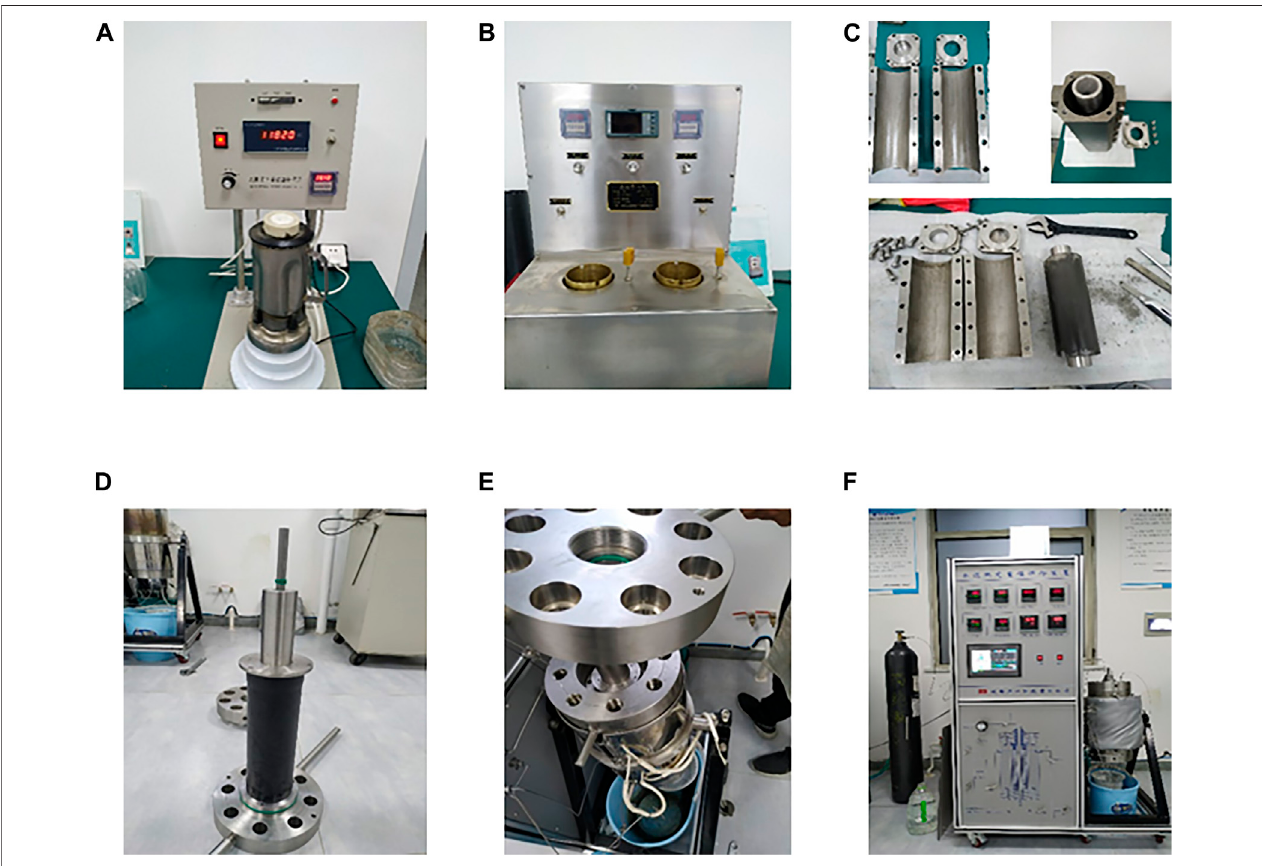
FIGURE3| Test process for cement ring integrity: (A) Preparation ofcementslurry, (B) Cement slurryprefabrication, (C) Mold assemblyand molding, (D) Cement ring assembly, (E) Instrument assembly, (F) conducting of the experiment.